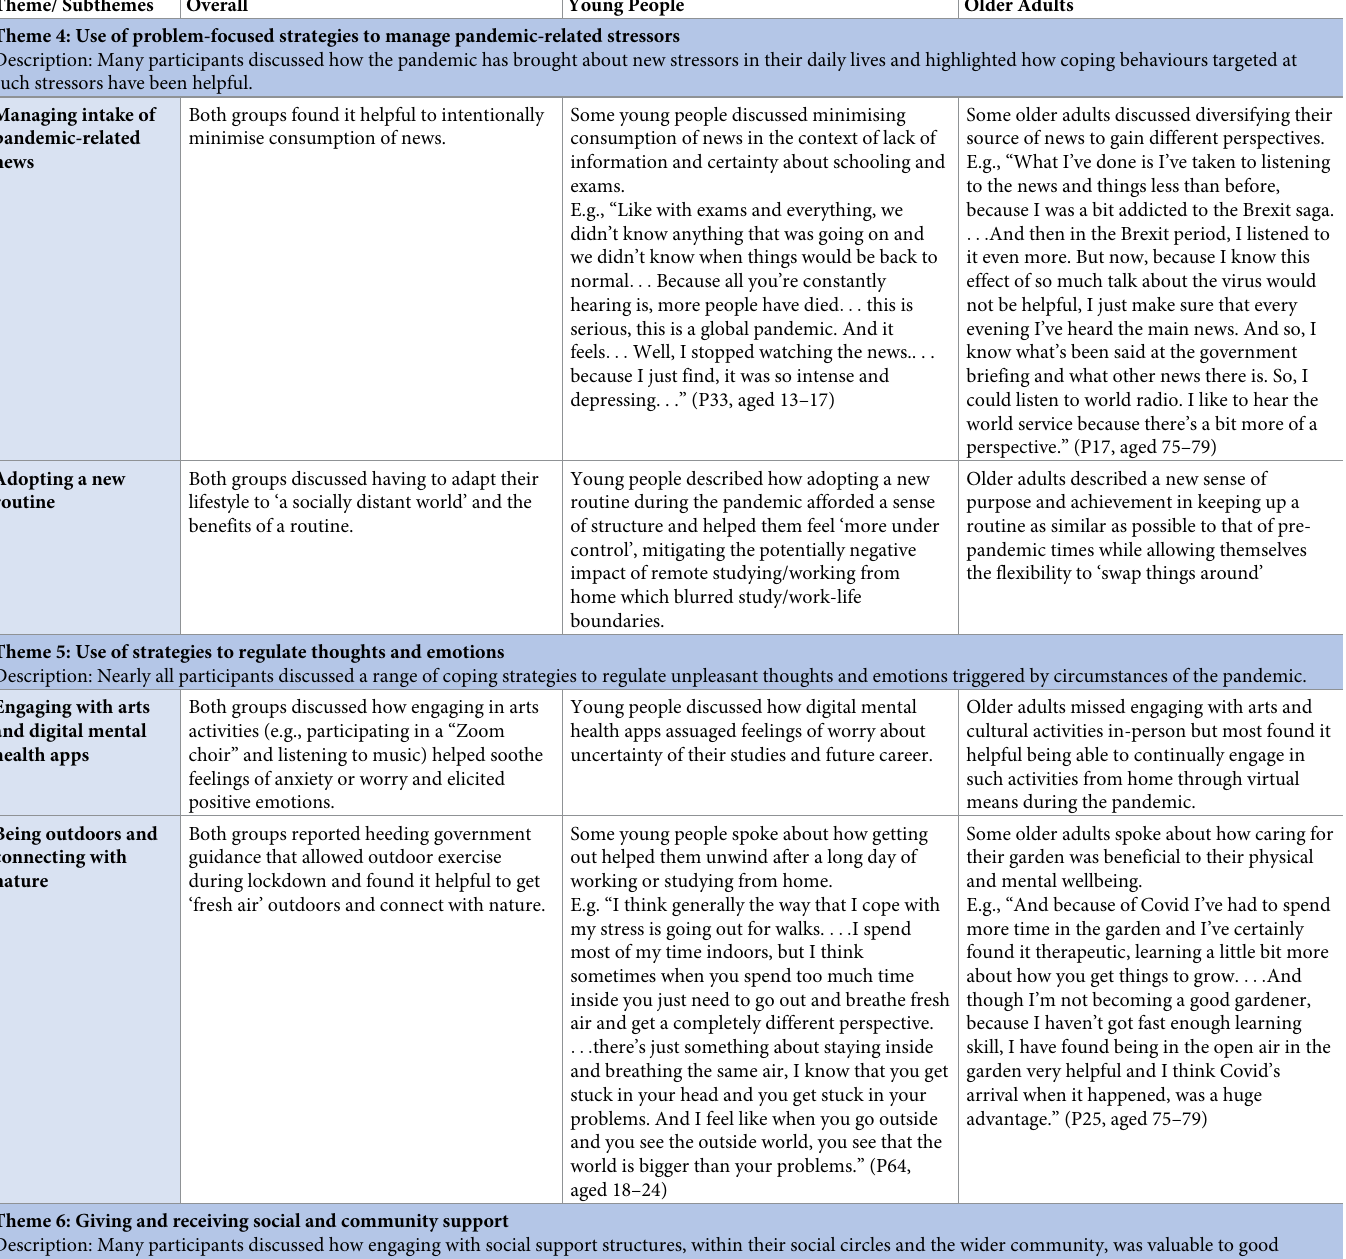
Table 3. Themes and subthemes on helpful coping behaviours, with summary of similarities and differences between young and older participants. Theme/ Subthemes